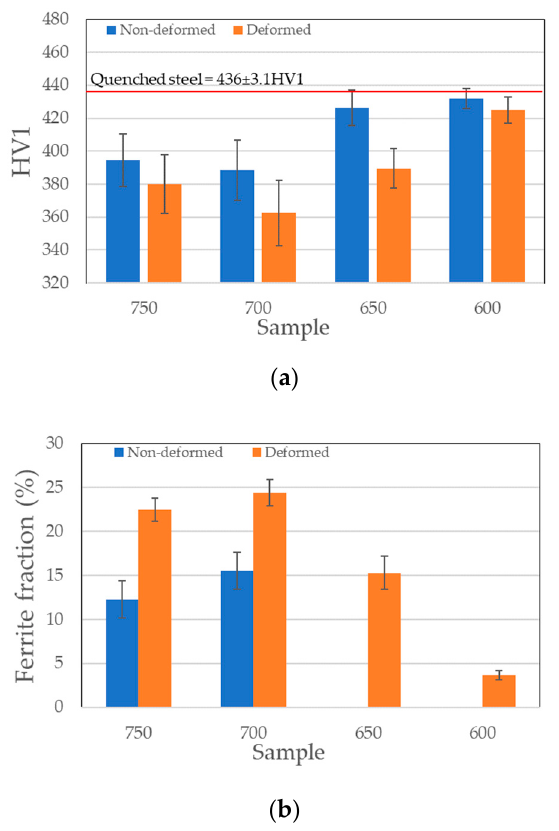
Figure 8. Comparison of: ( a ) hardness and ( b ) ferrite fraction for both groups of samples.